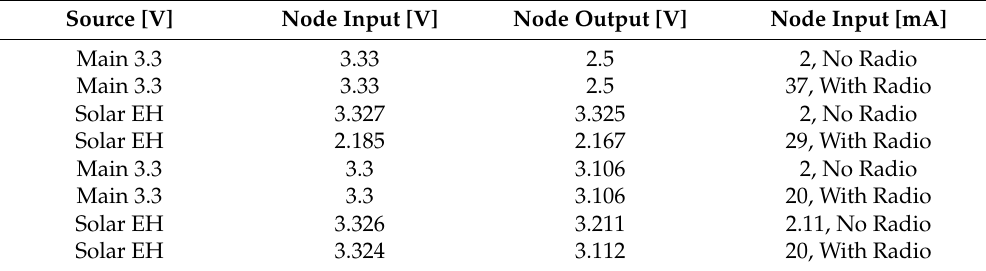
Table 2. First to fourth rows: measured voltage and current for the MSP-EXP430FR5739+CC2500 used as a transmitter. Fifth to eighth rows: measured voltage and current for